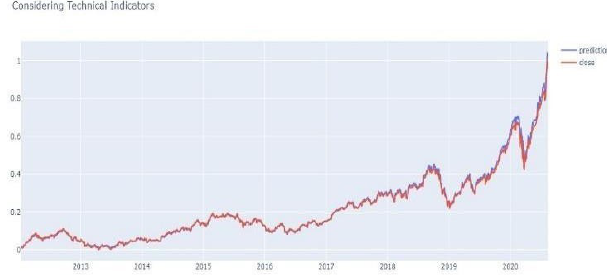
Fig. 2. Prediction using LSTM including technical